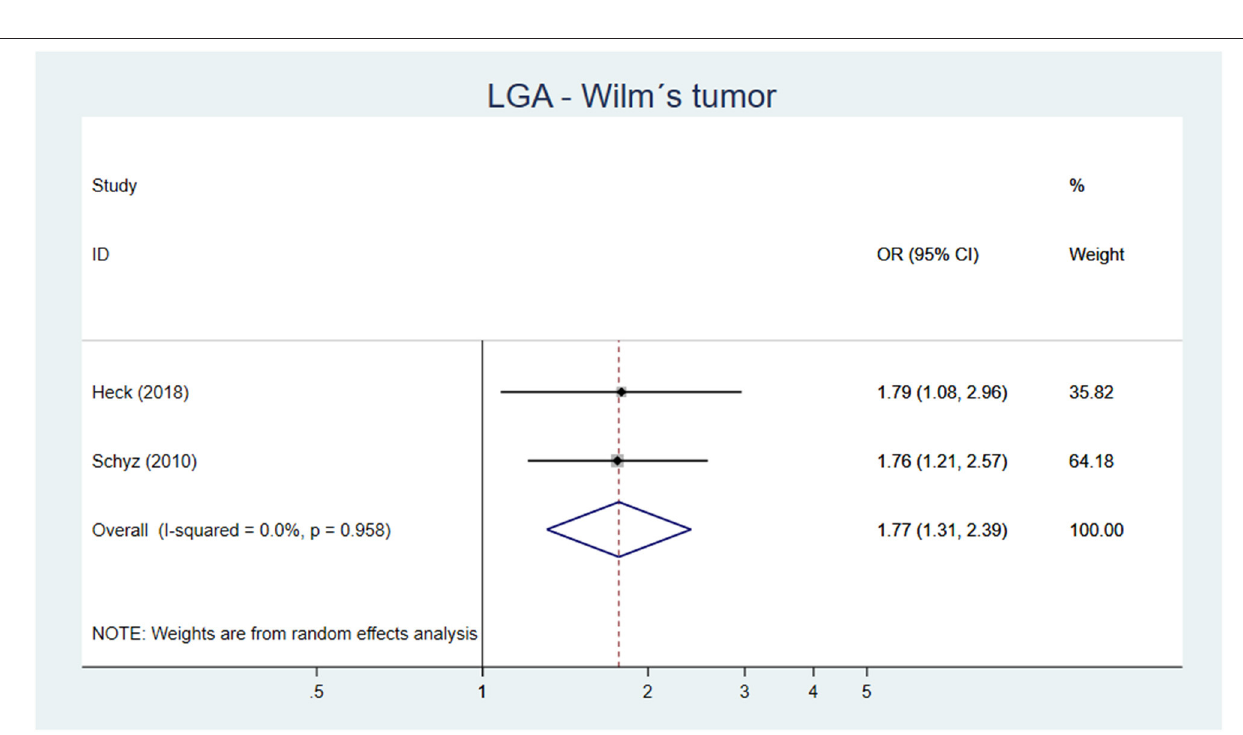
FIGURE 8 | Forest plot describing the association between LGA and Wilm’s